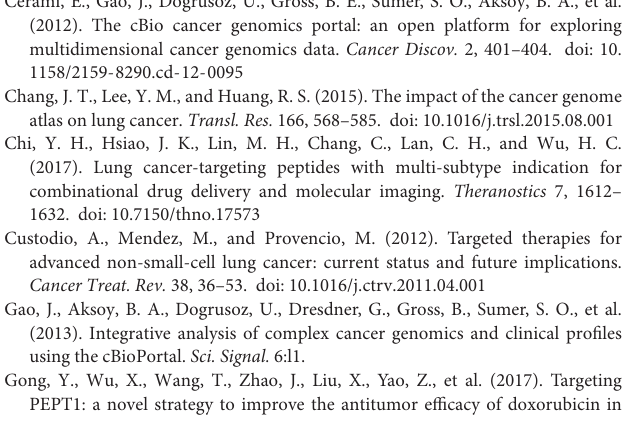
Supplementary Figure 1 | SLC15A family associations with clinical stages and mutation rate. (A) Violin plots of the SLC15A gene family in NSCLC for major stages (TNM stage system). (B) The mutation rate in the TCGA-NSCLC data cohort from cBioPortal using TCGA NSCLC 2016 cohort. A1 = SLC15A1, A2 = SLC15A2, A3 = SLC15A3, and A4 = SLC15A4. Supplementary Figure 2 | Volcano plot of all correlated genes of SLC15A4 in TCGA-LUAD with Pearson’s test. Green indicates negatively correlated genes; red indicates positively correlated